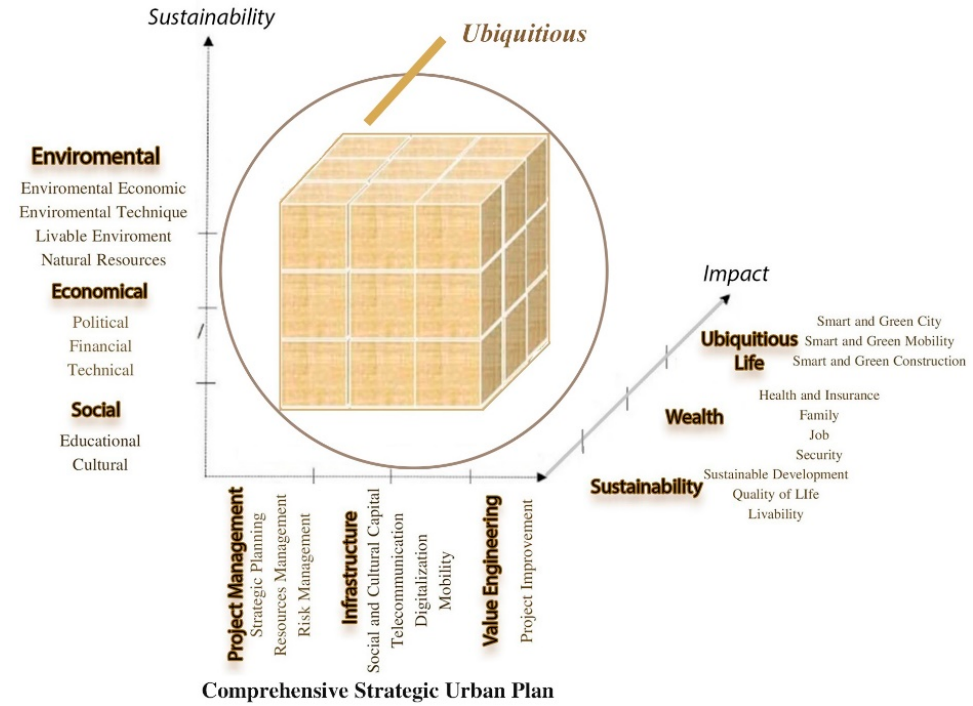
Figure 7. U-DSR Theory (Authors, [8,28]).